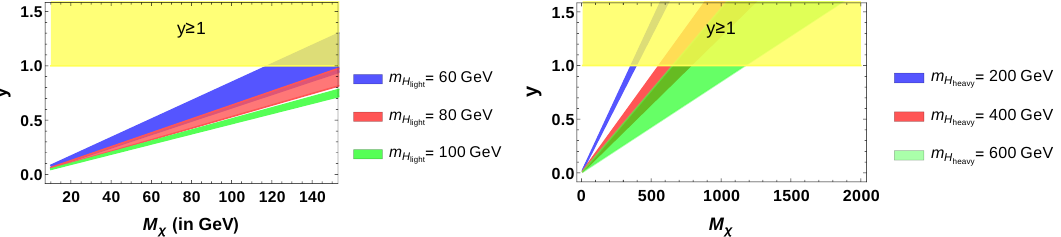
JHEP12(2018)007 =60, 80 and light =200, 400, heavy